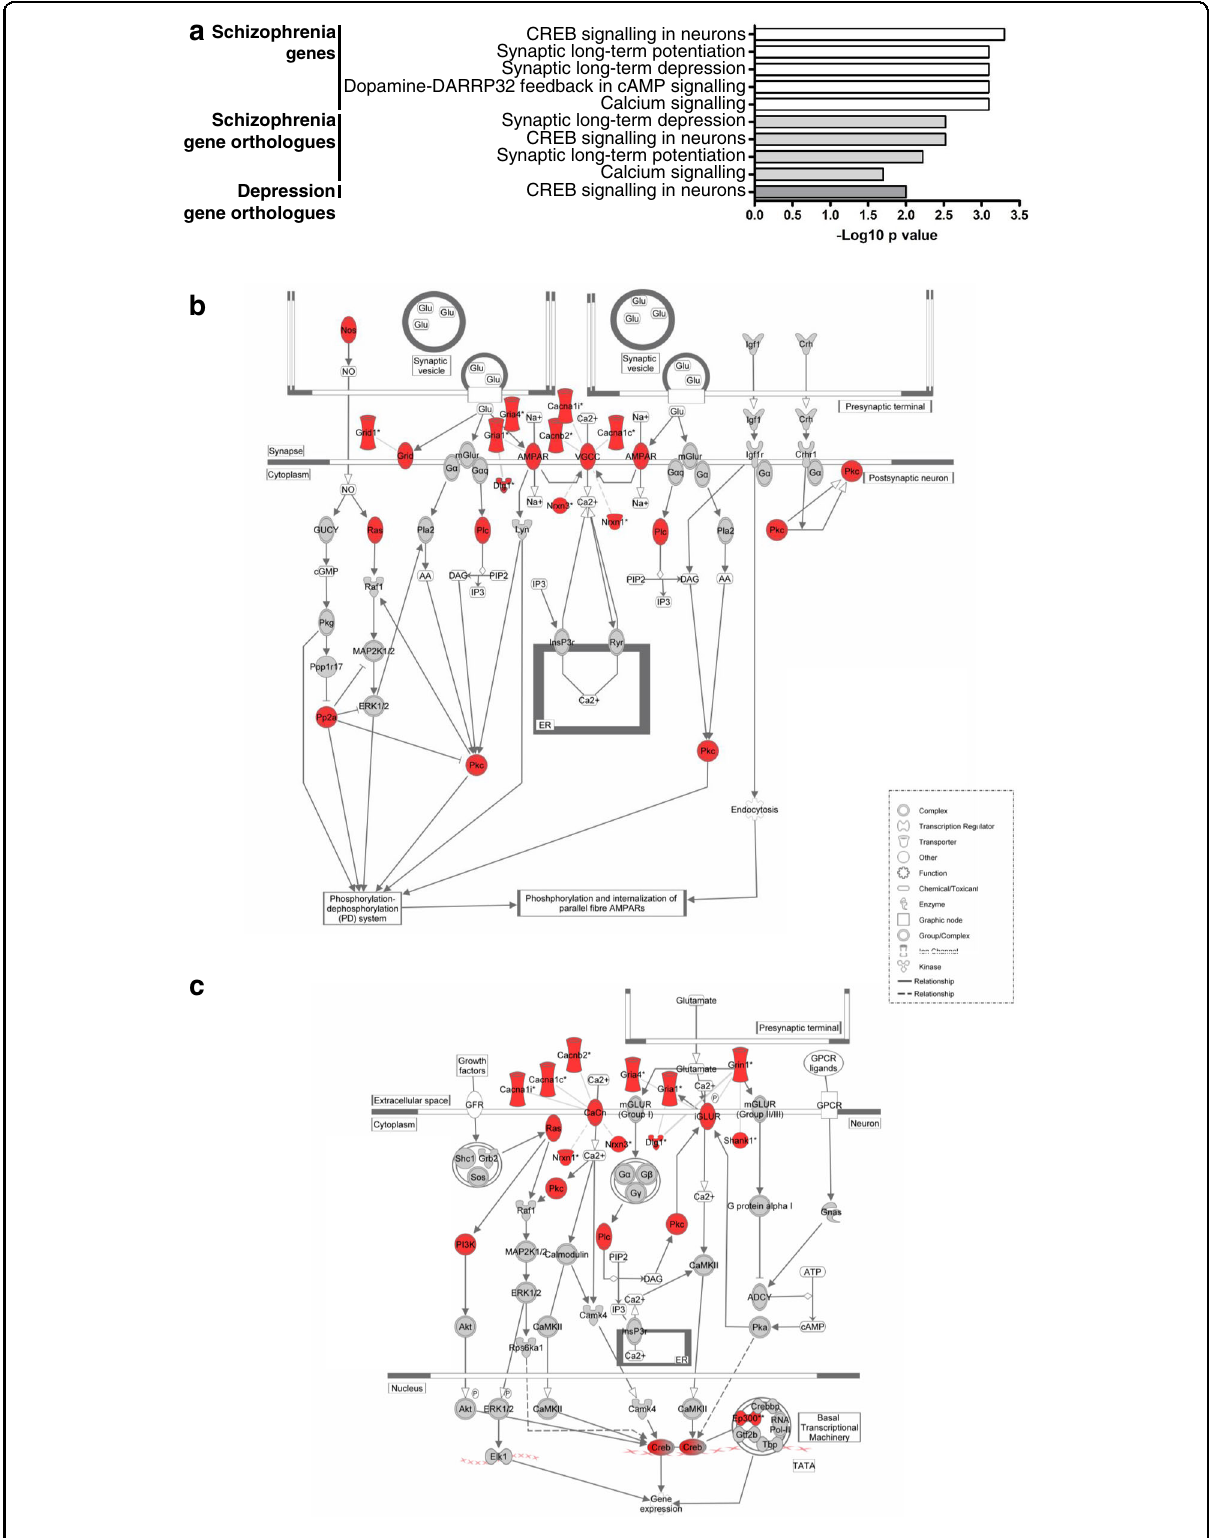
Fig. 3 (See legend on next